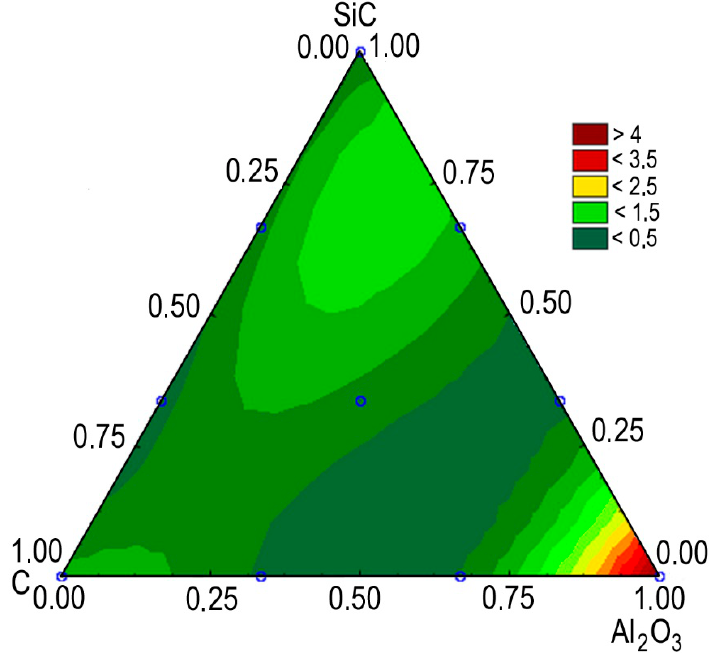
Figure 15. The e ff ect of the MMC composition on the wear rate, mm 3 / Figure 15. The effect of the MMC composition on the wear rate, mm 3 /h. Figure 15. The effect of the MMC composition on the wear rate, mm 3 /h.